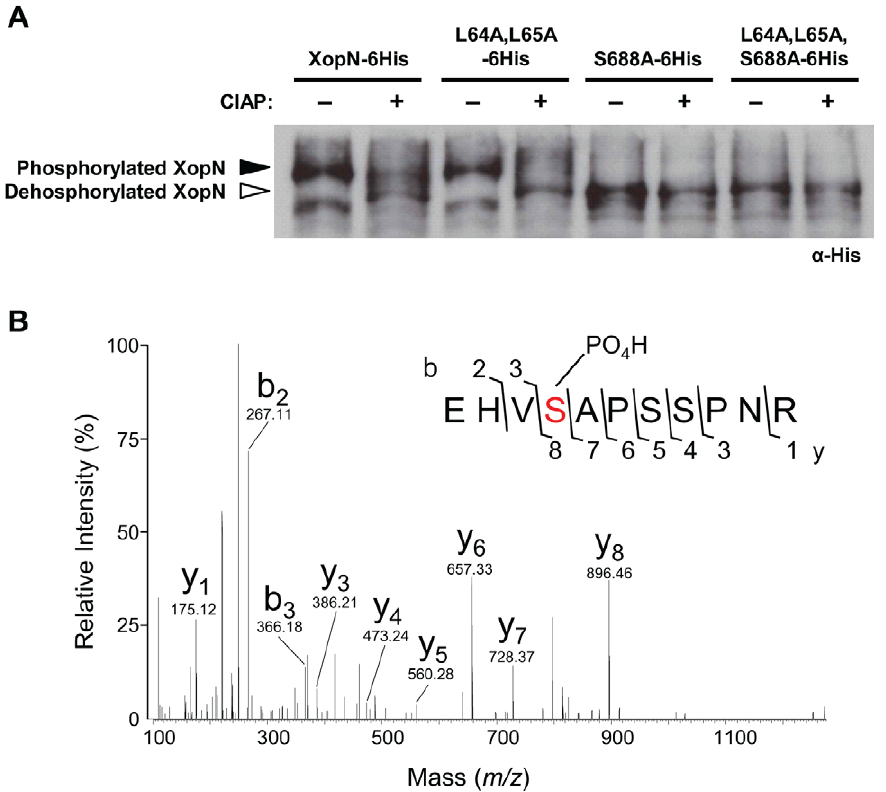
Figure 7. XopN is phosphorylated in plant extracts. ( A ) Phos-tag gel analysis of XopN-6His, XopN(L64A,L65A)-6His, XopN(S688A)-6His, or XopN(L64A,L65A,S688A)-6His purified from N. benthamiana leaves at 48 HPI by Ni + affinity chromatography. Protein was treated without or with CIAP for 60 min and then separated on 8% SDS-PAGE gels containing 50 m M Mn 2 + -Phos-tag. Gels were analyzed by immunoblot analysis using anti-His sera. ( B ) MS analysis of a XopN phosphopeptide isolated from N. benthamiana leaf extracts. The graph shows the fragmentation spectrum of the phosphopeptide EHVSAPpSSPNR. Serine 688 is phosphorylated. Major identified b- and y- ions are labeled. The m/z value for each b- and y- ion is